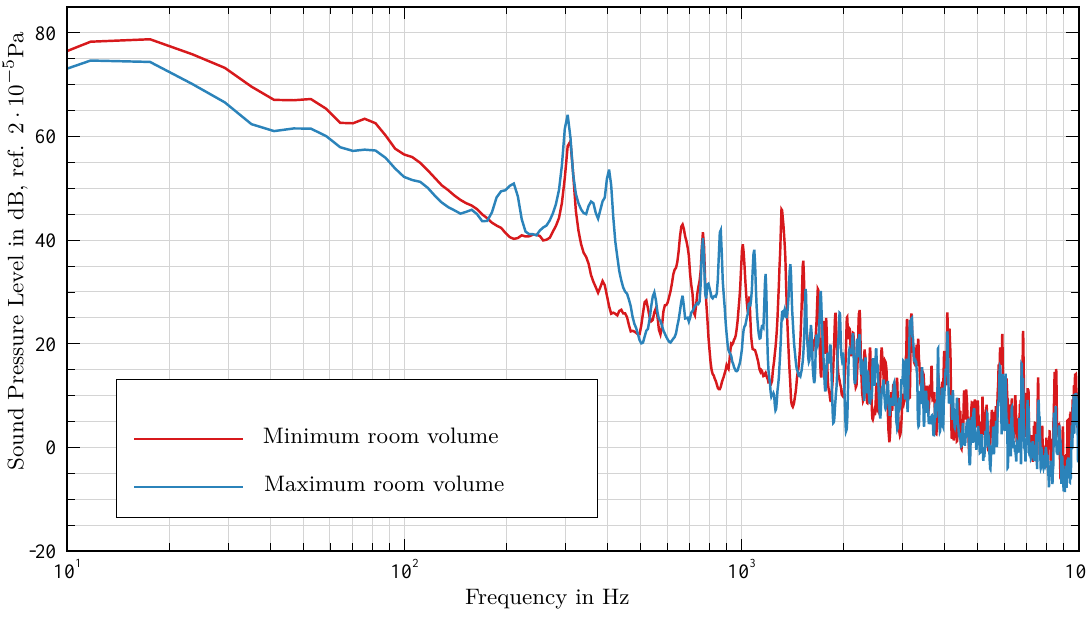
Figure 12. Sound Pressure Level at variation of the room